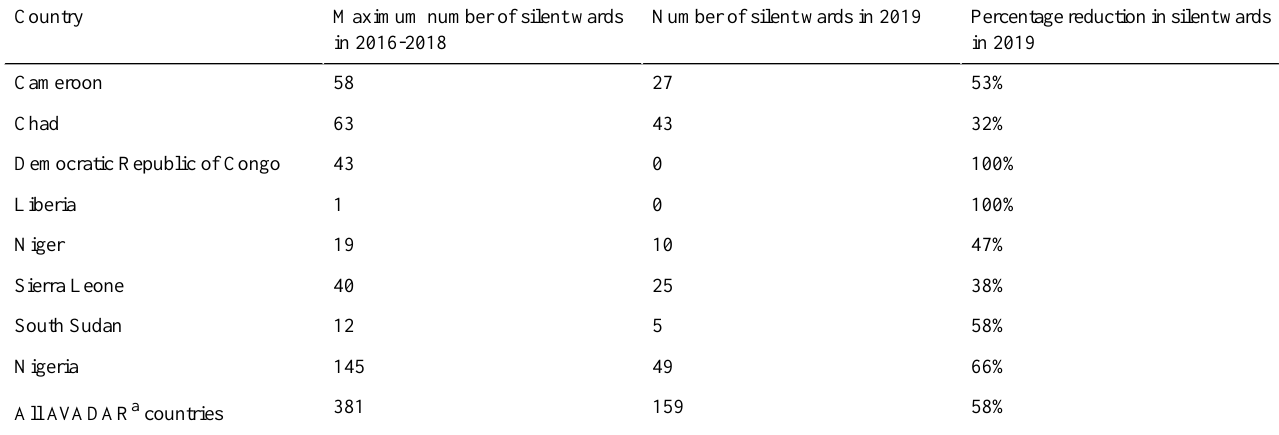
Table 3. Impact of Auto-Visual Acute Flaccid Paralysis Detection and Reporting (AVADAR) in eight countries on the reduction in silent health areas in 2016-2018 compared with 2019 (aggregated comparison).